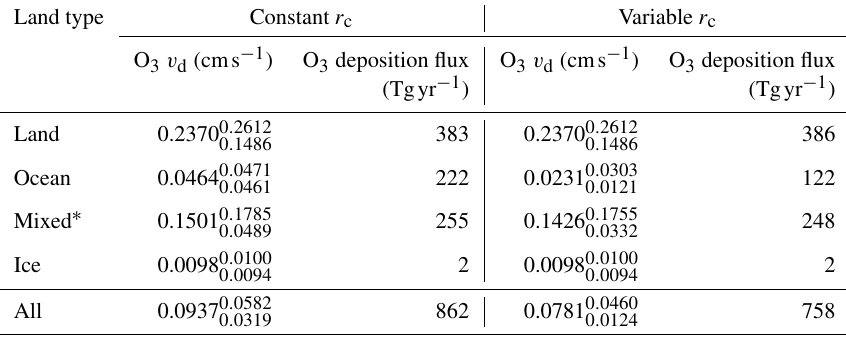
Table 1. Area-weighted annual average deposition velocity and deposition flux for 2014 by land type for ozone in GEOS-Chem using the default (constant) and new (variable) scheme for calculating r c . The 25th and 75th percentiles are the subscripts and superscripts respectively for each land type’s deposition velocity. The average deposition velocities and 25th and 75th percentiles were calculated from monthly average model values for grid boxes containing 100% of the land type specified unless otherwise stated.